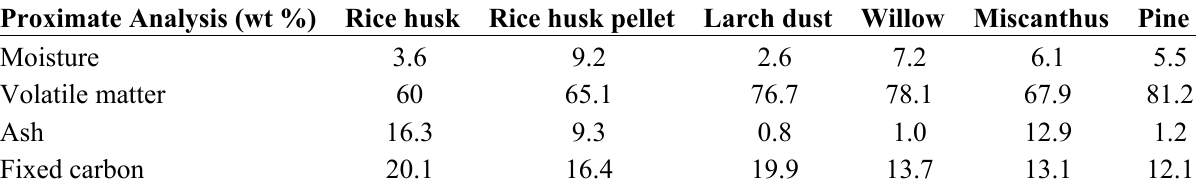
Table 1. Properties of woody biomass samples